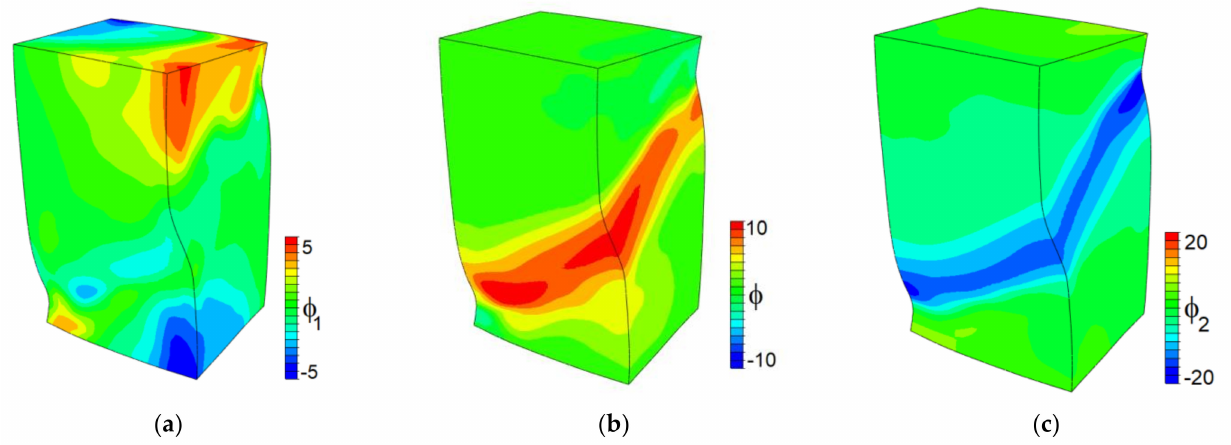
Figure 12. Distributions of Euler angles φ 1 ( a ), φ ( b ), and φ 2 ( c ) in the single crystal with {100} faces under compression along the [001] axis at a strain of